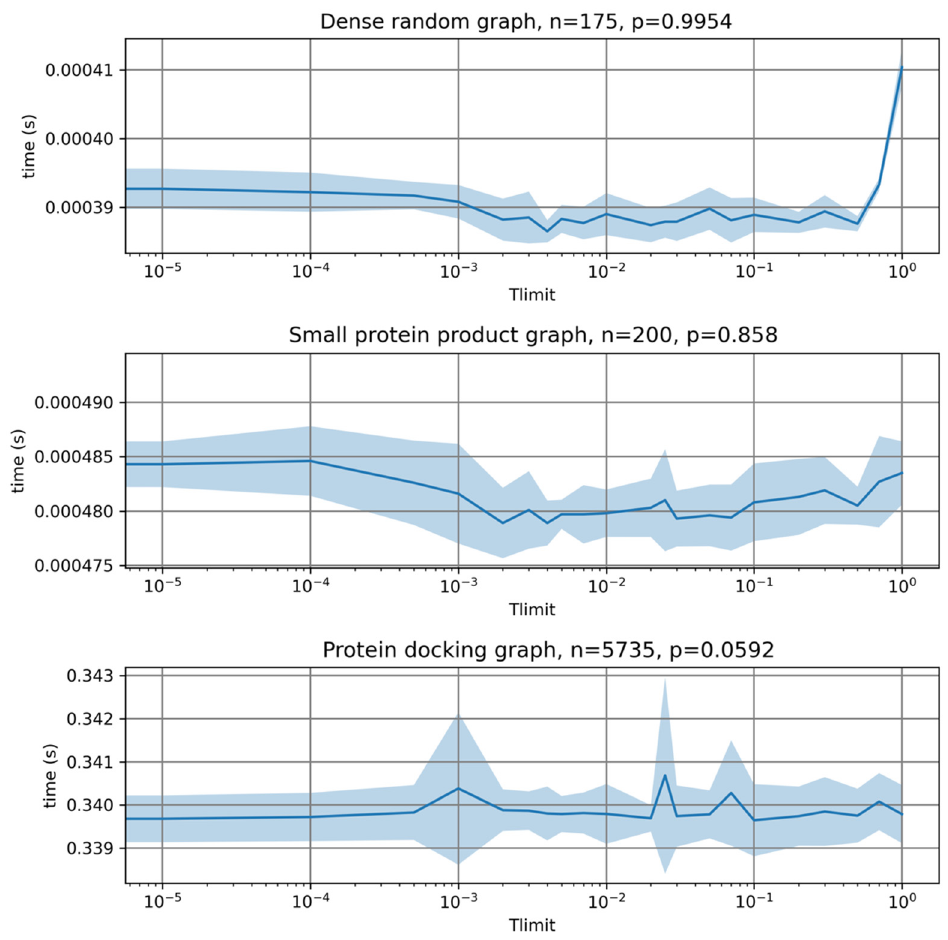
Figure 3. Time needed by the MCQD algorithm to find the maximum clique on different graphs independent of Tlimit. The blue line represents the mean time and the shaded area represents standard deviation over 20 runs of the MCQD algorithm. Table 2. R 2 values from different machine learning